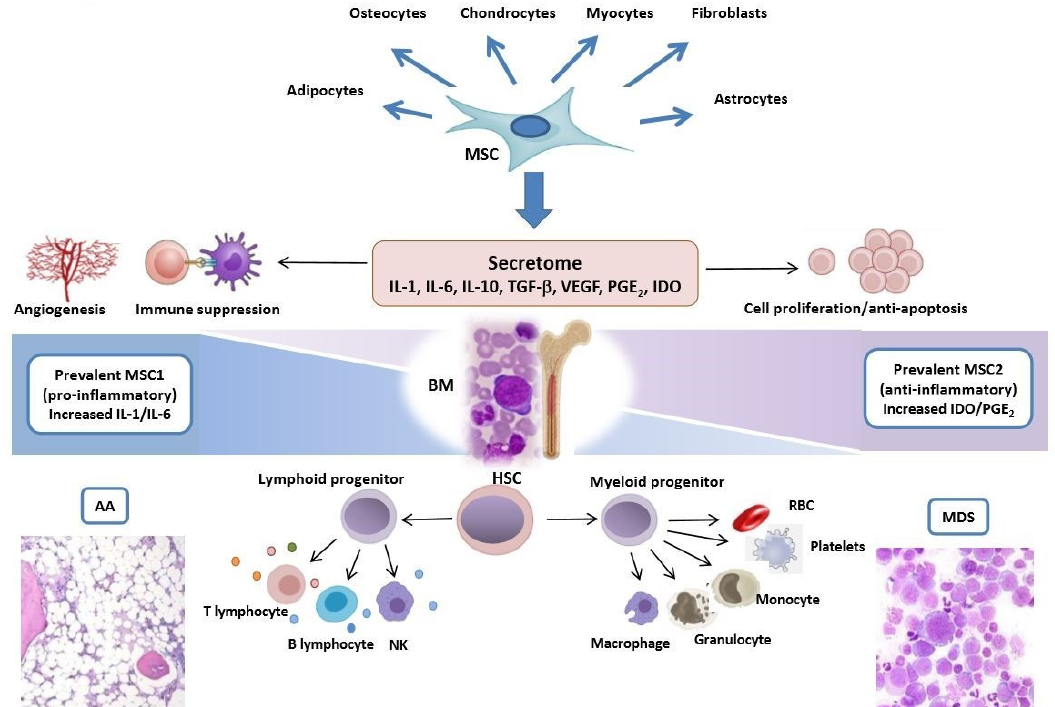
Figure 1. Multiple functions of mesenchymal stem cells in aplastic anemia and myelodysplastic syndromes. Mesenchymal stem/stromal cells (MSCs) are multipotent cells that are able to differentiate and transdifferentiate in different tissues (e.g., bone, cartilages, adipose tissue). They exert a supportive and modulating effect on the bone marrow (BM) niche and on innate and adaptive immunity via the secretion of soluble mediators (secretome). Various MSC alterations are described in AA and MDSs, including increased immunosuppression, decreased angiogenesis (prevalent in the former) and deregulated proliferation/apoptosis (prevalent in the latter). These phenomena may be mirrored by a phenotypic shift from type 1 (proinflammatory/immunosuppressive) to type 2 (anti-inflammatory / tumor-educated) MSCs along the clinical spectrum of BM failure syndromes. IL-1, interleukin-1; IL-6, interleukin-6; IL-10, interleukin-10; TGF −β, transforming growth factor- β ; PGE 2 , prostaglandin E 2 ; IDO, indoleamine 2,3-dioxygenase; MSC 1/2, type 1/2 MSC; HSC, hematopoietic stem cell; NK, natural killer; RBC, red blood cell.